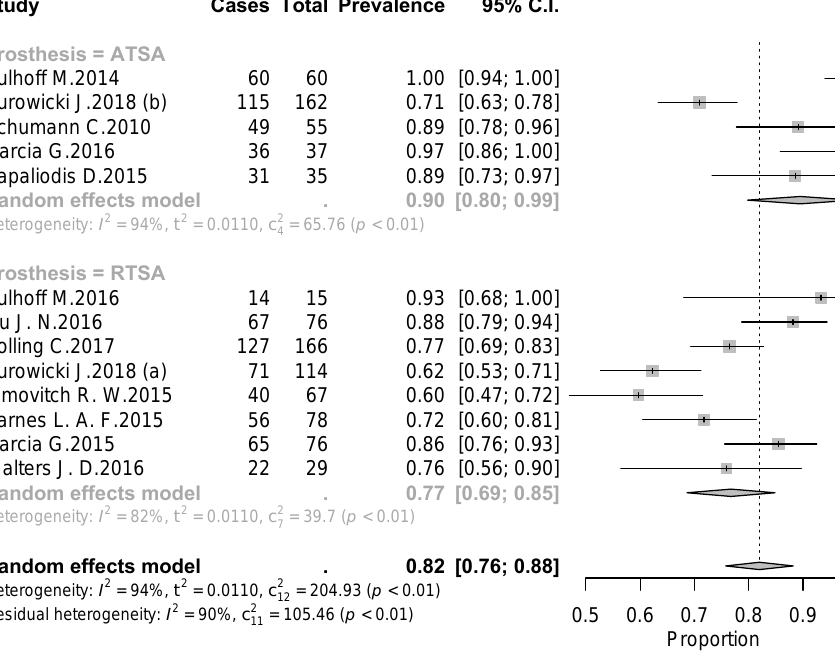
Figure 2. Forest plot chart of the combined rate of return to sports by meta-analysis with 95% confidence interval. ATSA, anatomic total shoulder arthroplasty; RTSA, reverse total shoulder arthroplasty.